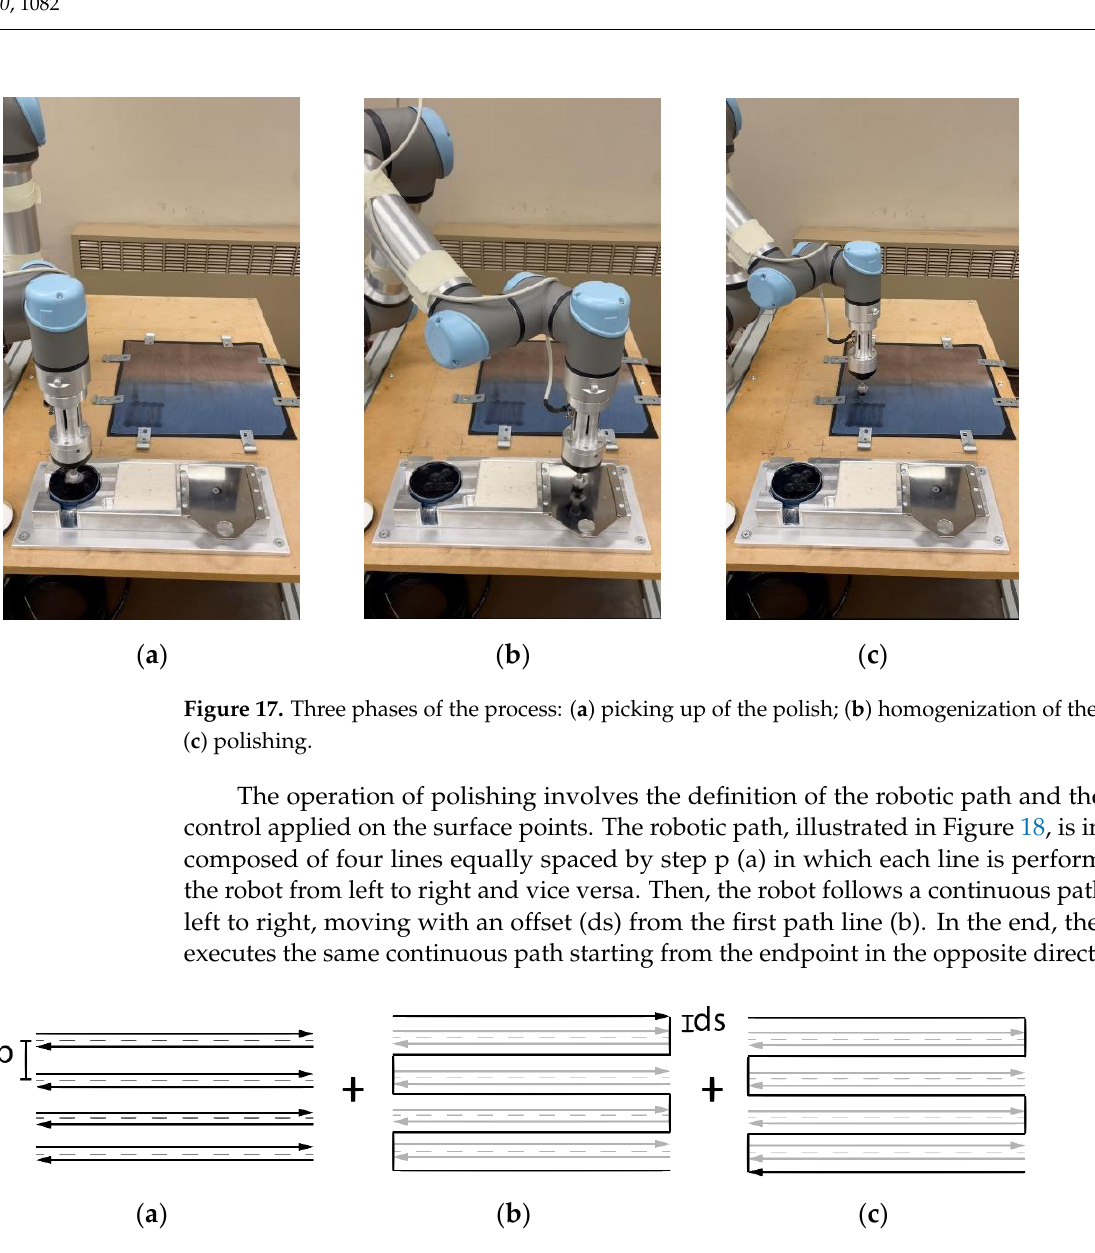
Figure 18. Polishing path: ( a ) Four lines separated by the step (p); ( b ) First continuous path with offset ds; ( c ) Second continuous path with offset ds.